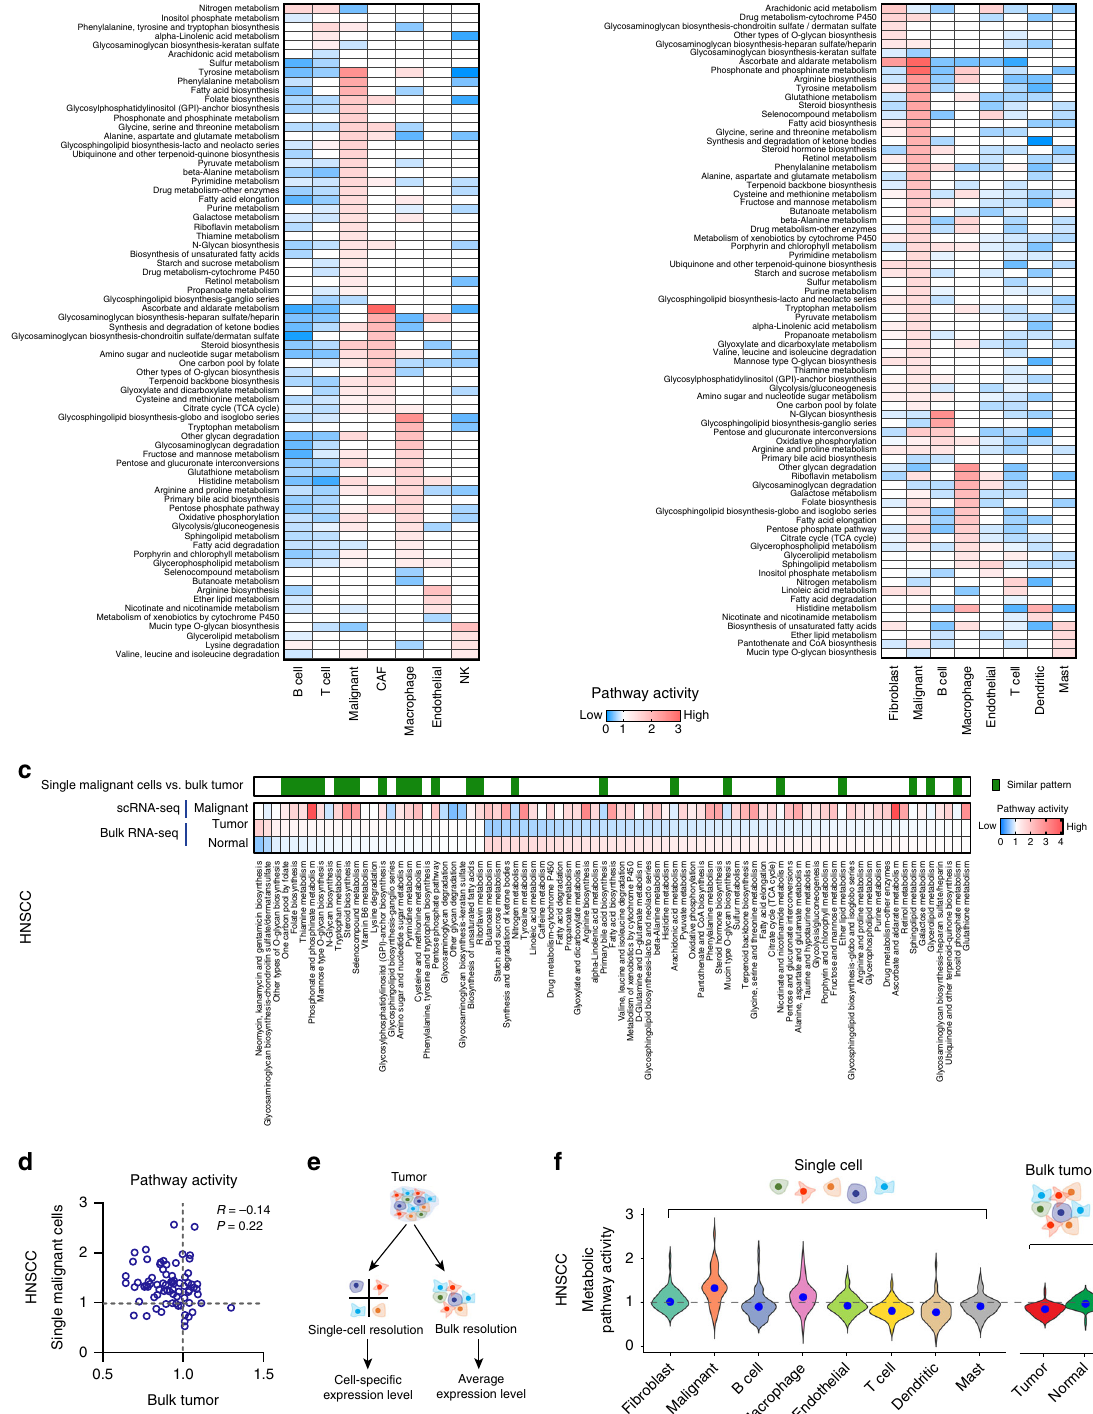
Fig. 2 Cell type-speci fi c metabolic reprogramming. a Metabolic pathway activities in cell types in the melanoma dataset. Statistically non-signi fi cant values (random permutation test p > 0.05) are shown as blank. b Metabolic pathway activities in cell types in the HNSCC dataset. Statistically non-signi fi cant values (random permutation test p > 0.05) are shown as blank. c Metabolic pathway activities in HNSCC tumor samples and matched adjacent normal samples from TCGA computed based on bulk RNA-seq data. The color bar on the top marks the pathways with similar activity changes in single malignant cells compared to single non-malignant cells and bulk tumors compared to normal tissue samples. d Scatter plot comparing pathway activities between bulk HNSCC tumors in TCGA and single malignant cells in the HNSCC scRNA-seq dataset. e Difference between bulk and single-cell RNA-seq in characterizing gene expression pro fi les in tumors. f Distributions of pathway activities in different cell types from the HNSCC scRNA-seq dataset (left) and in bulk tumors and normal samples from TCGA